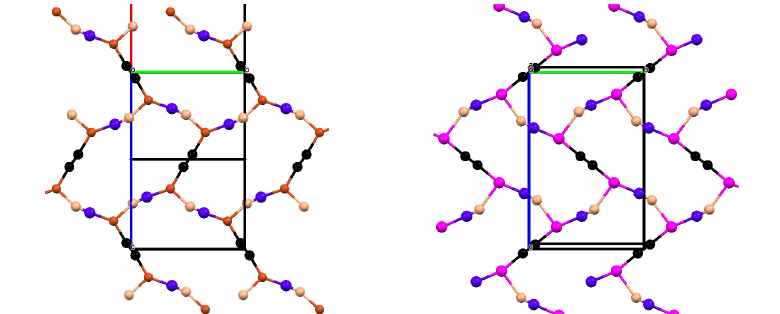
Figure 12. View of the anion network of κ -CuCN ( Left ) and κ -AgCN ( Right ) in the bc plane projected along the a ∗ -axis. Cooper and silver are colored in red and violet, respectively. Carbon and nitrogen of ordered CN − groups are colored in blue and orange, while they are colored in black for CN − groups located at inversion centers. The unit cell is marked as a